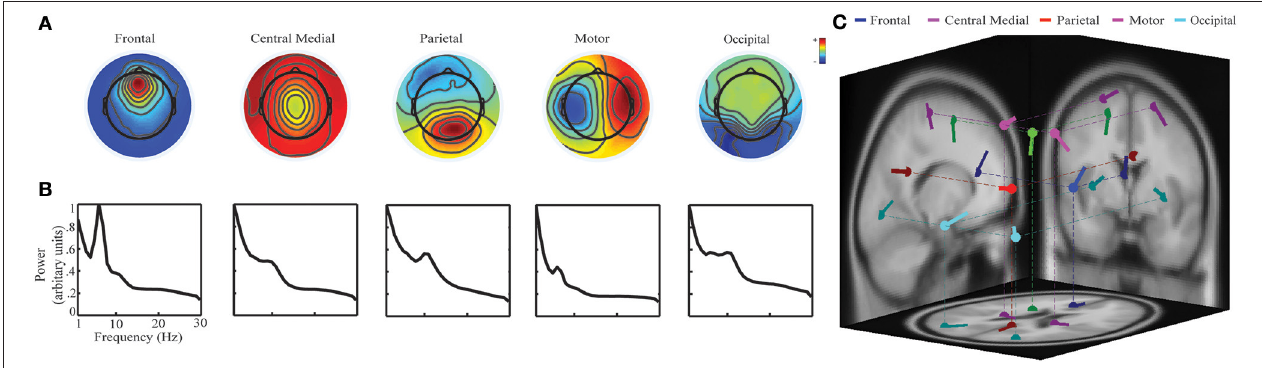
FIGURE 2 | Five brain activity related ICs identified using group-level ICA: (A) spatial scalp maps; (B) averaged PSDs; and (C) dipole source locations on the MNI